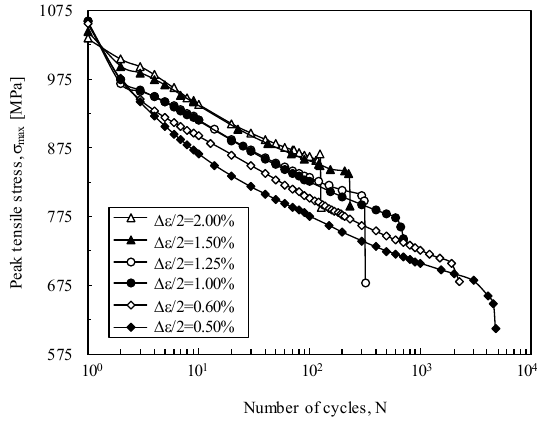
Figure 5. Evolution of the peak tensile stress with the number of cycles.